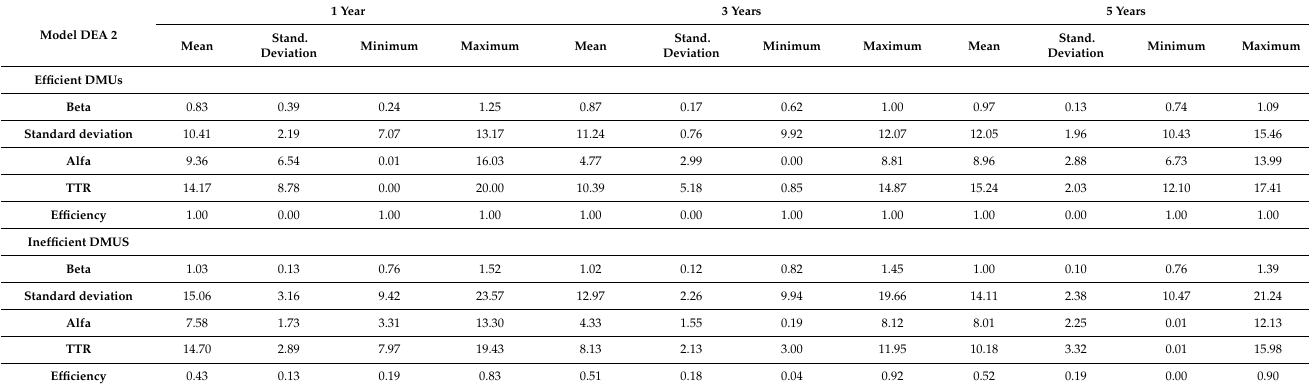
Table A8. Descriptive statistics of efficient and inefficient DMUs in model